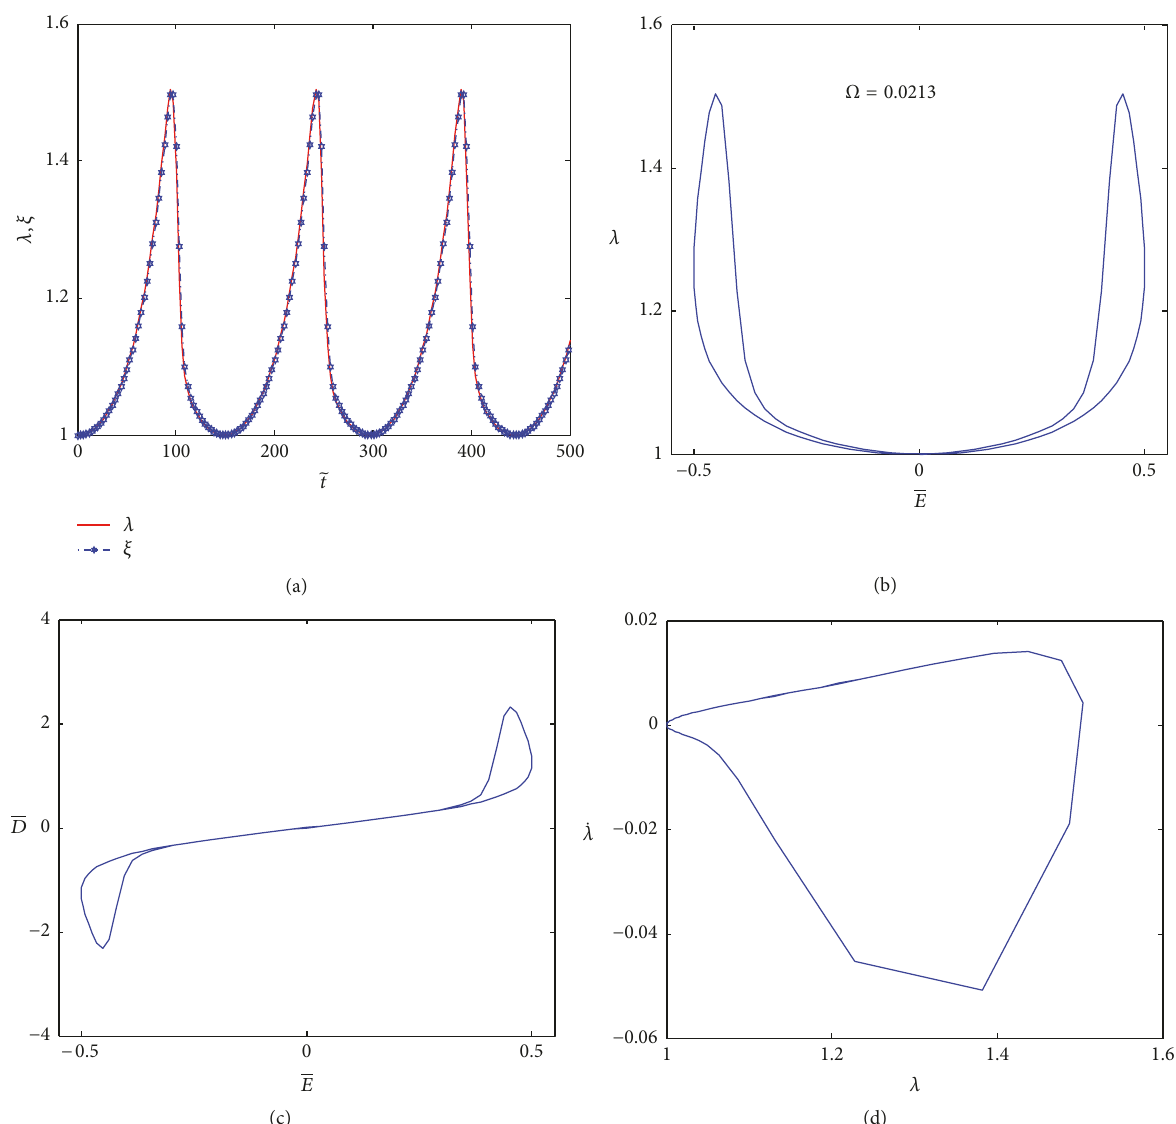
Figure 7: The total stretch 𝜆 , the viscous stretch 𝜉 (a), the nominal electric field-stretch response (b), the nominal electric field-nominal electric displacement (c), and the phase diagram (d) for the dimensionless frequency Ω = 0.0213